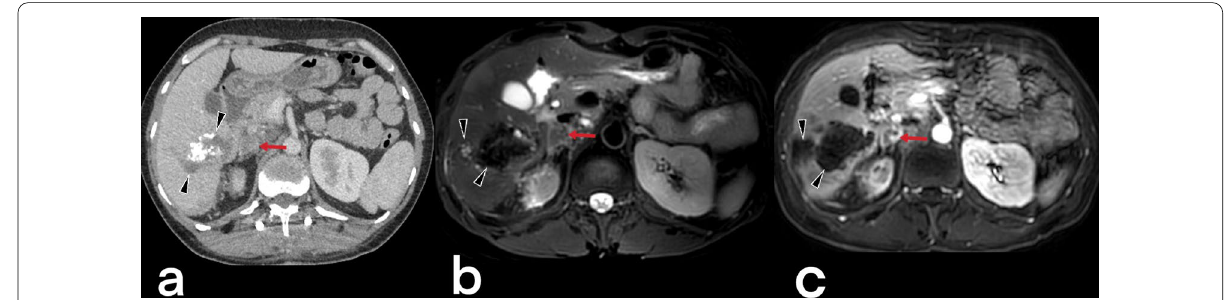
Fig. 35 A 52-year-old female. Contrast-enhancement CT ( a ), T2 weighted MR ( b ), and contrast-enhancement T1 weighted MR ( c ) images demonstrate a heterogeneous lesion with peripheral enhancement (arrows) in the right adrenal gland (adrenal TB). Multiple calcified heterogeneous areas (arrowheads) are also seen in the liver (hepatic